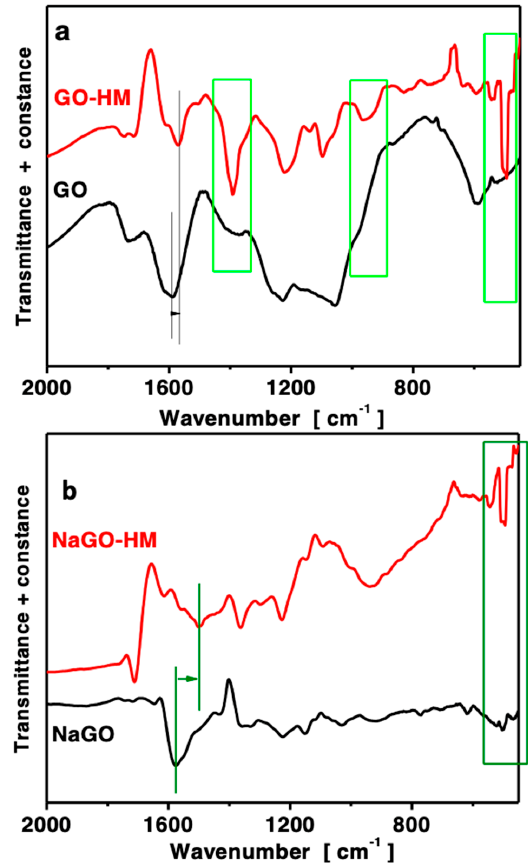
Figure 3. FTIR spectra for GO ( a ) and NaGO ( b ) before and after metal ion adsorption (HM).